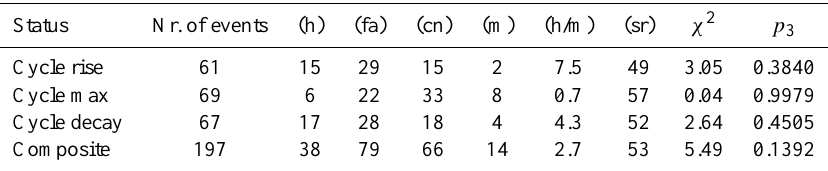
Table 4. Performance of the HAFv.2 model with respect to the prediction of SATs in association with a population of minor flares of X-ray classes C1-C9 during the key phases of solar cycle 23 and during the total cycle.